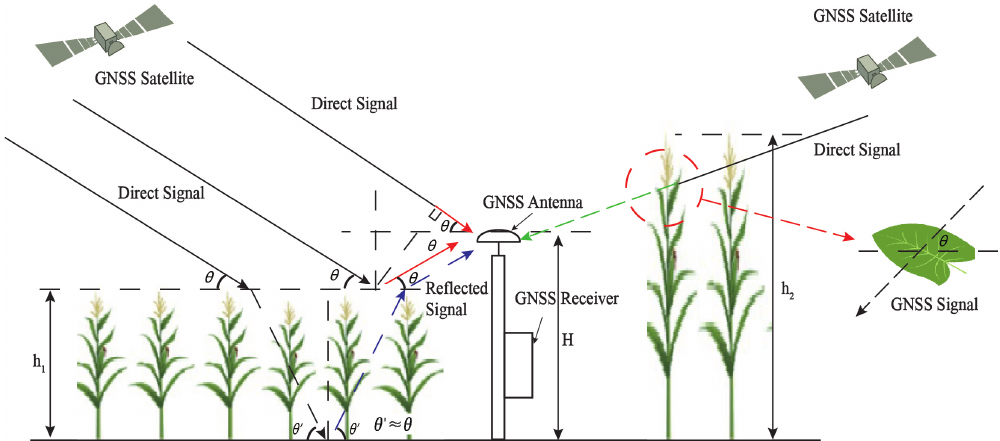
Figure 1. Geometry of the line-of-sight GNSS signal transmission, reflected by the corn canopy and soil surface, and obscured by